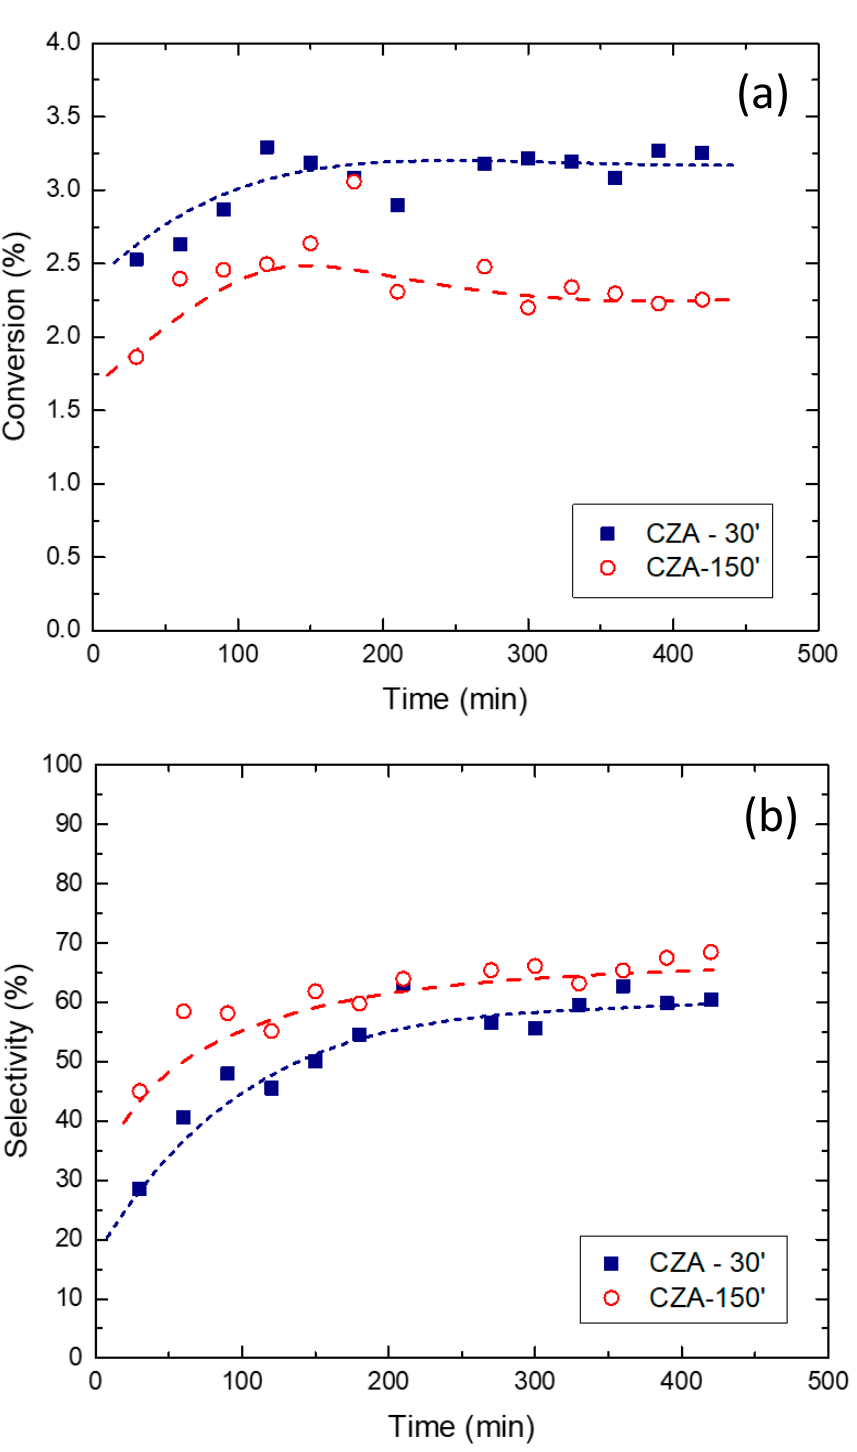
Figure 6. ( a ) Conversion and ( b ) selectivity for CZA-30 ́ at 210 °C. Figure 7 shows the comparison of the carbon dioxide conversion with CZA-30 ′ and CZA-150 ′ . As the precipitation time increases, the conversion becomes poorer, which is probably related with the lower surface area of the latter. Although the selectivity is greater when the synthesis time is larger, as the conversion has such a small value, the better yield was given by CZA-30 ′ (1.63% vs. 1.45%).